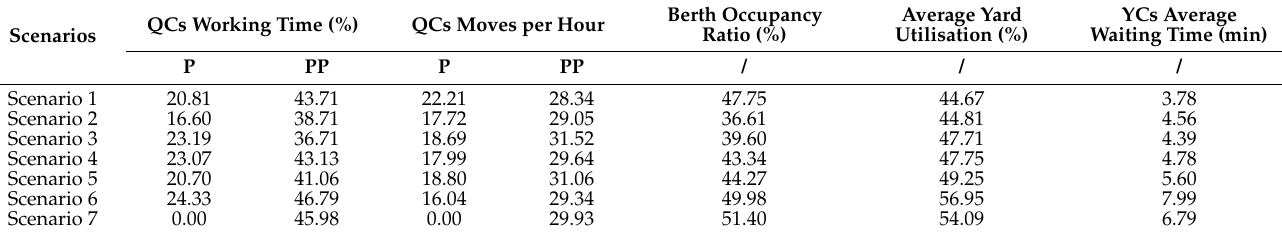
Table 2. Results of the fourth set of simulations.